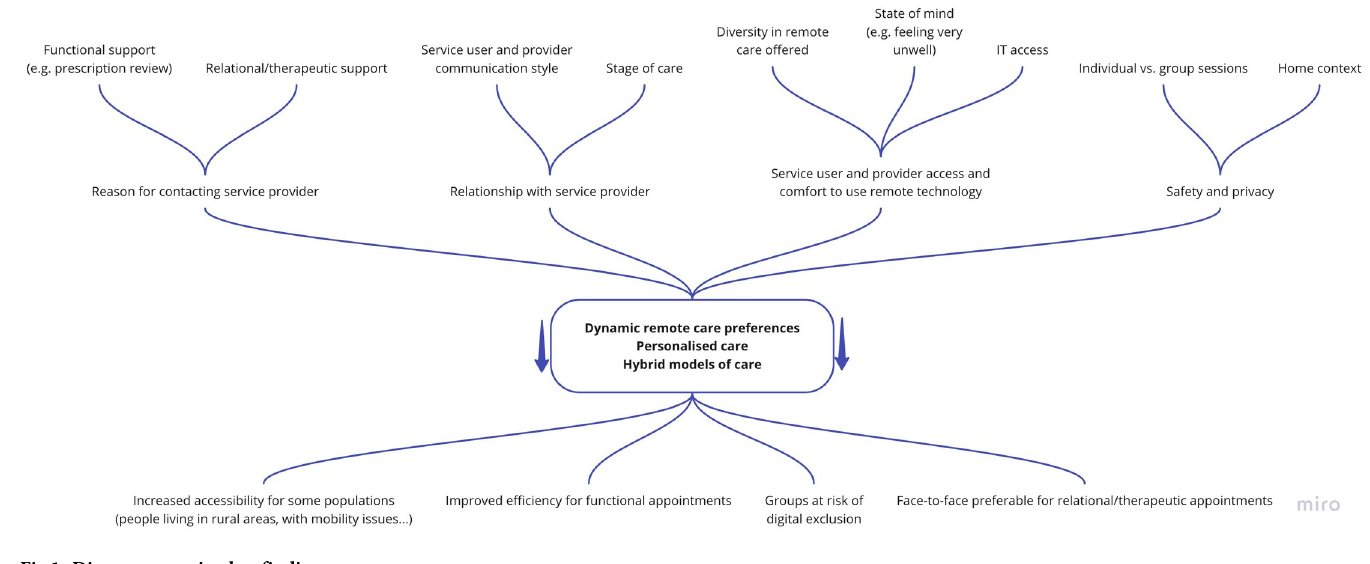
Fig 1. Diagram mapping key